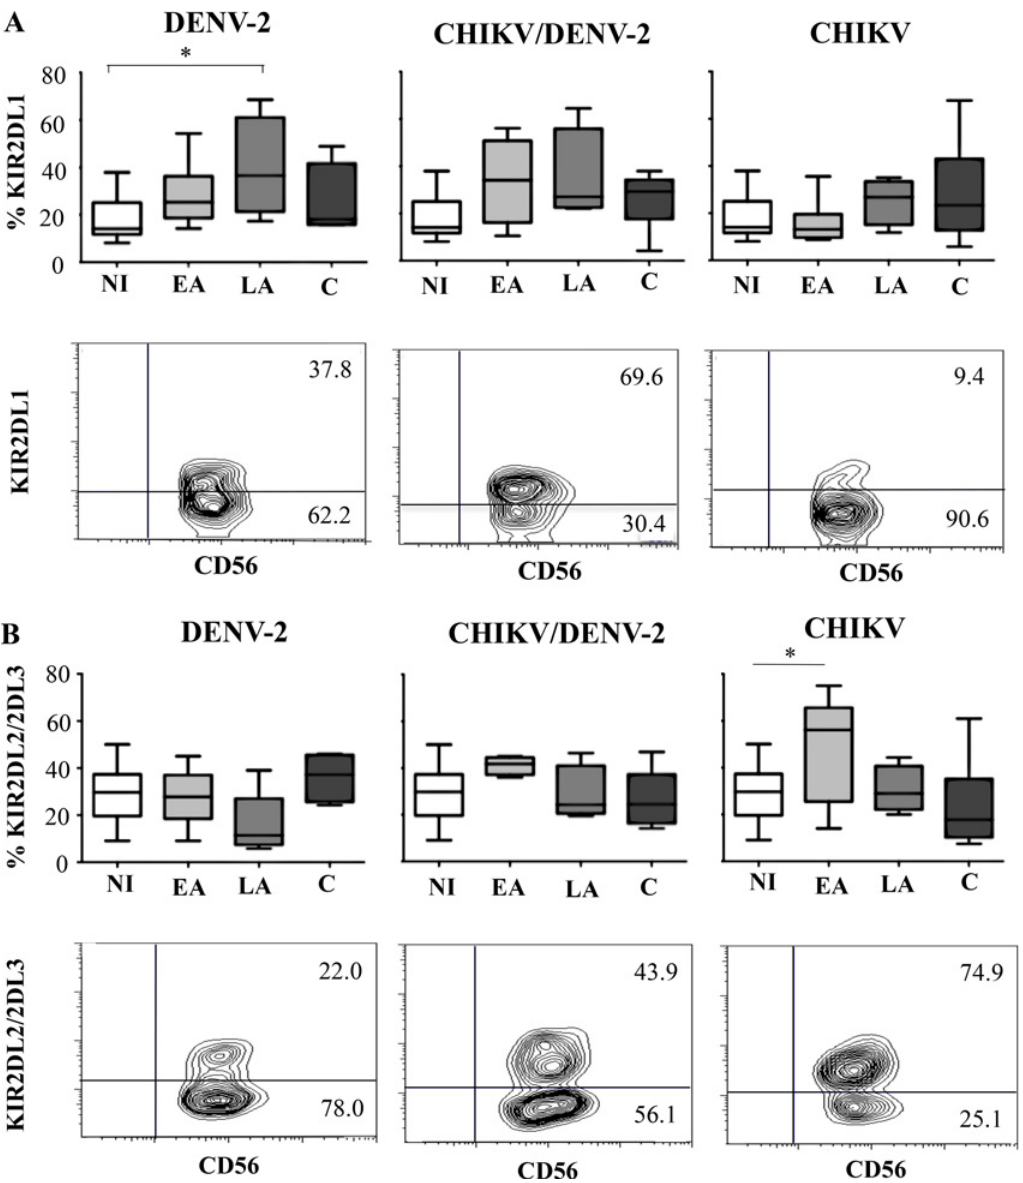
Fig 3. Association of KIR2DL1 expression and DENV-2 infection. Results are grouped according to type of infection: DENV-2, CHIKV or co-infected by CHIKV and DENV-2 (CHIKV/DENV-2), and compared to non-infected Gabonese healthy controls (NI). Samples from infected patients were collected in early acute (EA; day (D)0-D3), late acute (LA; D12-D15) and convalescent (C; D > 30) stages post-onset of symptoms. Frequency of KIR2DL1 (A) and KIR2DL2/ 2DL3 (B) gated on CD3 - CD56 + NK cells. Dot-plots show only cells from EA patients. * p < 0.05, ** p <